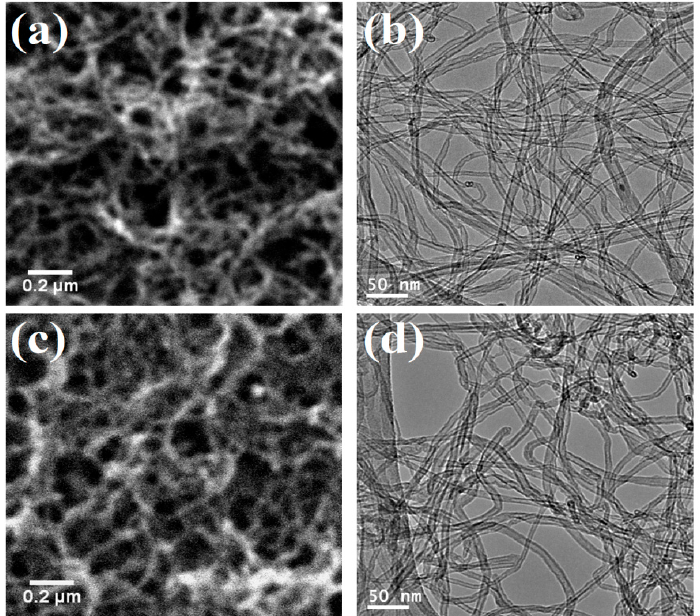
Figure 4. Scanning electron microscope images of the functionalized carbon nanotubes: ( a ) oxidized CNTs and ( c ) polymer functionalized CNTs. High resolution transmission electron microscope (HRTEM) images of the functionalized carbon nanotubes: ( b ) oxidized CNTs and ( d ) polymer functionalized